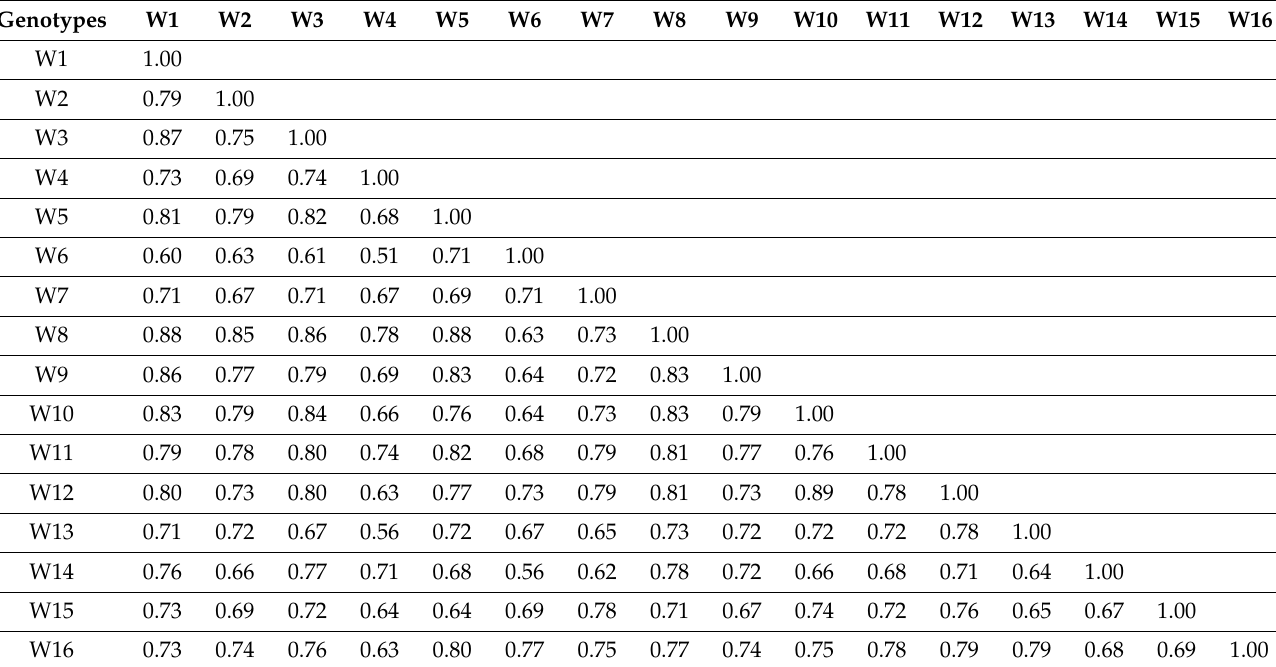
Table 7. Genetic similarity of 16 T. aestivum genotypes by Jaccard’s coefficient using UPGMA algo- rithm based on ISSR and SCoT banding